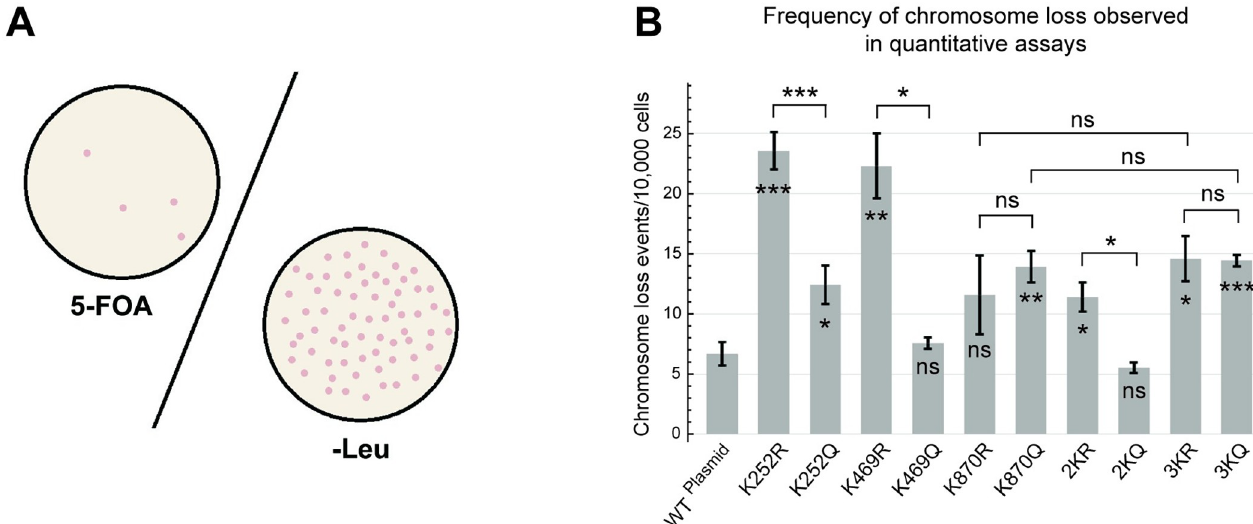
Fig 8. Manipulation of Stu2 acetylation sites alters chromosome transmission fidelity. Yeast strains for this assay contained a 125 kb artificial chromosome that expressed the URA3 gene, in addition to plasmids expressing WT-Stu2 (yRM12253), K252R (yRM12261), K252Q (yRM12262), K469R (yRM12301), K469Q (yRM12260), K870R (yRM12652), K870Q (yRM12270), 2KR (yRM12266), 2KQ (yRM12267), 3KR (yRM12269), and 3KQ (yRM12268) in a stu2 - Δ 1:: HIS3 background. (A) To quantify the frequency at which the artificial chromosome was lost in Stu2 mutants, the cells were transferred to plates containing 5-FOA or serially diluted and transferred to -leu synthetically defined plates. Because 5-FOA is toxic to yeast possessing the URA3 gene, only colonies that have lost the 125 kb artificial chromosome should grow on 5-FOA. Colonies growing on leucine deficient plates reflect the total number of cells used in the experiment. (B) Quantitative rates of chromosome transmission fidelity reflect the total number of colonies growing on 5-FOA media relative to colonies growing on -Leu synthetic deficient media following serial dilutions. Quantitative chromosomal loss data displayed as mean ± SEM of quadruplicate plates; � p < 0.05, �� p < 0.01, ��� p < 0.005 (raw quantitative data are available in S1 Supplementary file).